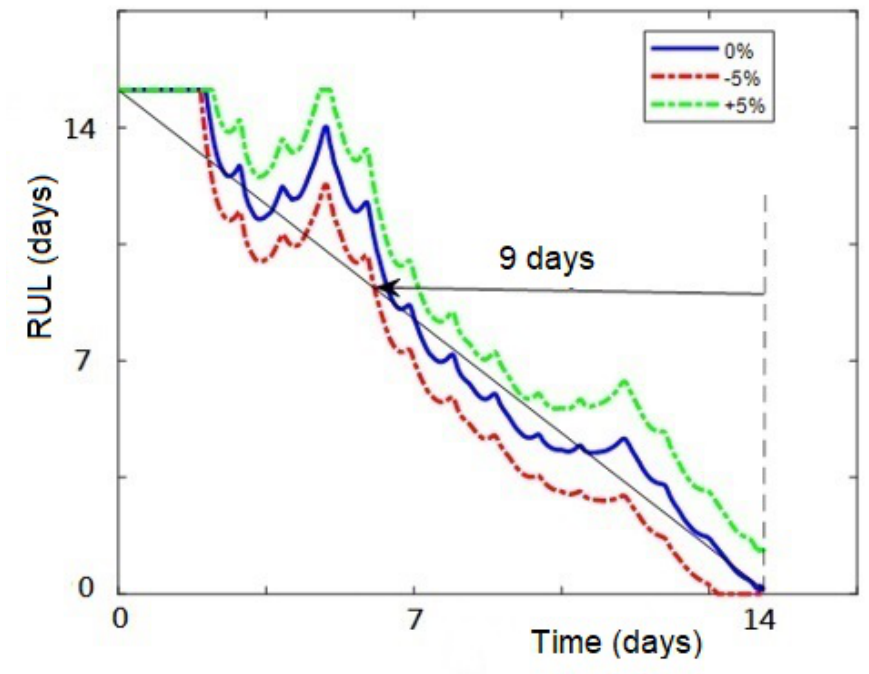
Figure 11. Remaining useful time to achieve minimal tank level in March